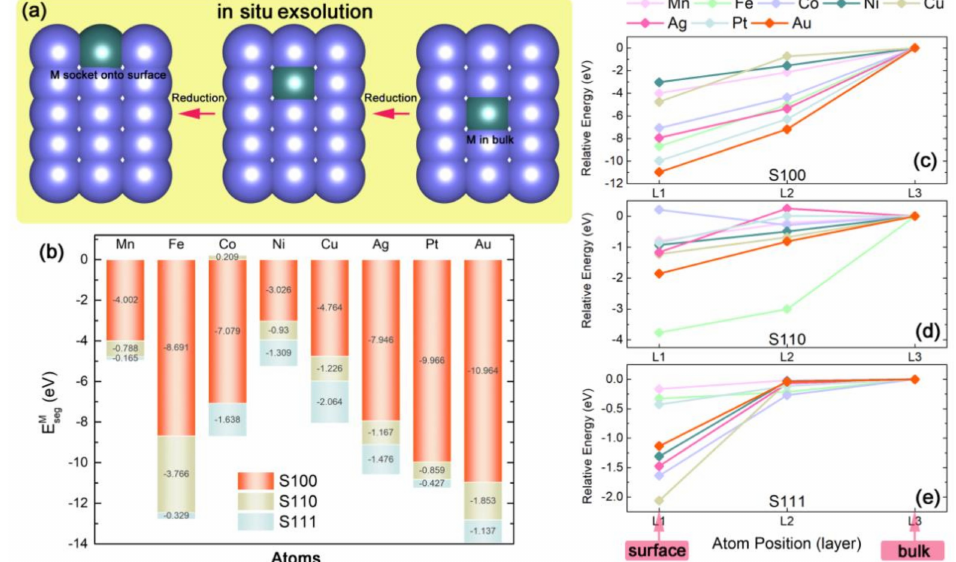
Figure 3. ( a ) The schematic diagram of metal M in-situ exsolution in term of atomic scale. ( b ) Evolution of the segregation energy E M seg for different oriented M x Ce 1 − x O 2 slabs as a function of M substitutions. ( c – e ) Relative energy of M x Ce 1 − x O 2 slabs of as a function of the position of metal atoms, ( c ) for S100, ( d ) for S110 and ( e ) for S111, the zero of energy is the energy of M x Ce 1 − x O 2 slabs with M in the “bulk” as the reference